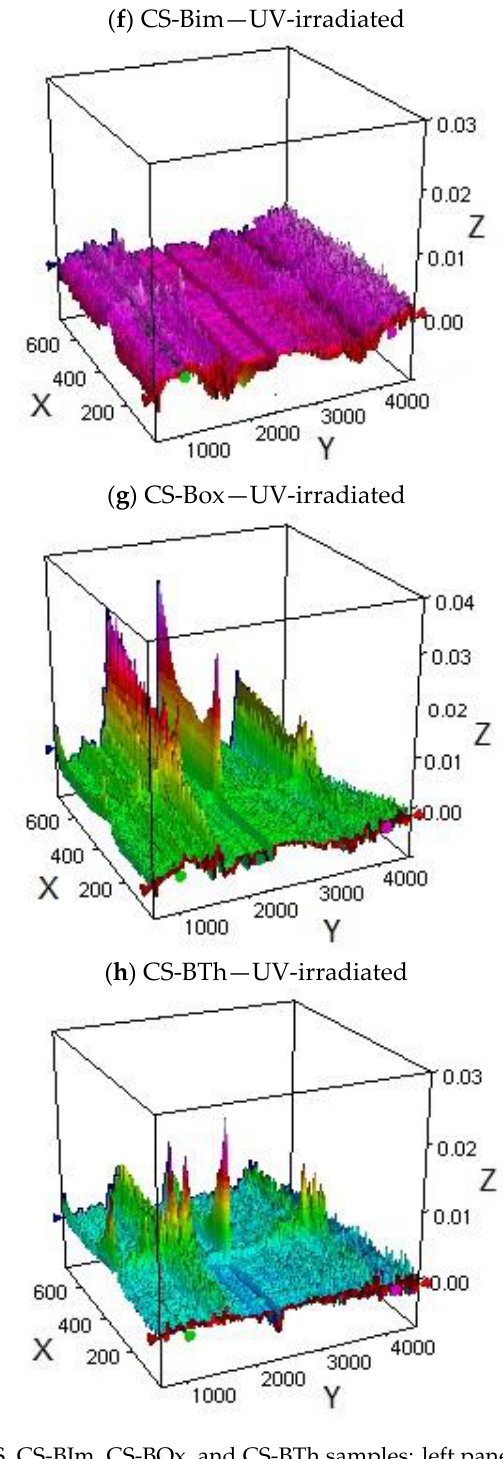
Figure 6. TGA-FTIR plots of CS, CS-BIm, CS-BOx, and CS-BTh samples: left panel — unirradiated samples ( a , c , e , g ); right panel—8 h UV irradiated samples ( b , d , f , h ). Axis description: X—temperature samples ( a , c , e , g ); right panel — 8 h UV irradiated samples ( b , d , f , h ). Axis description: X — tempera- ture (°C), Y — wavenumber (cm − 1 ), and Z — absorbance. ( ◦ C), Y—wavenumber (cm − 1 ), and